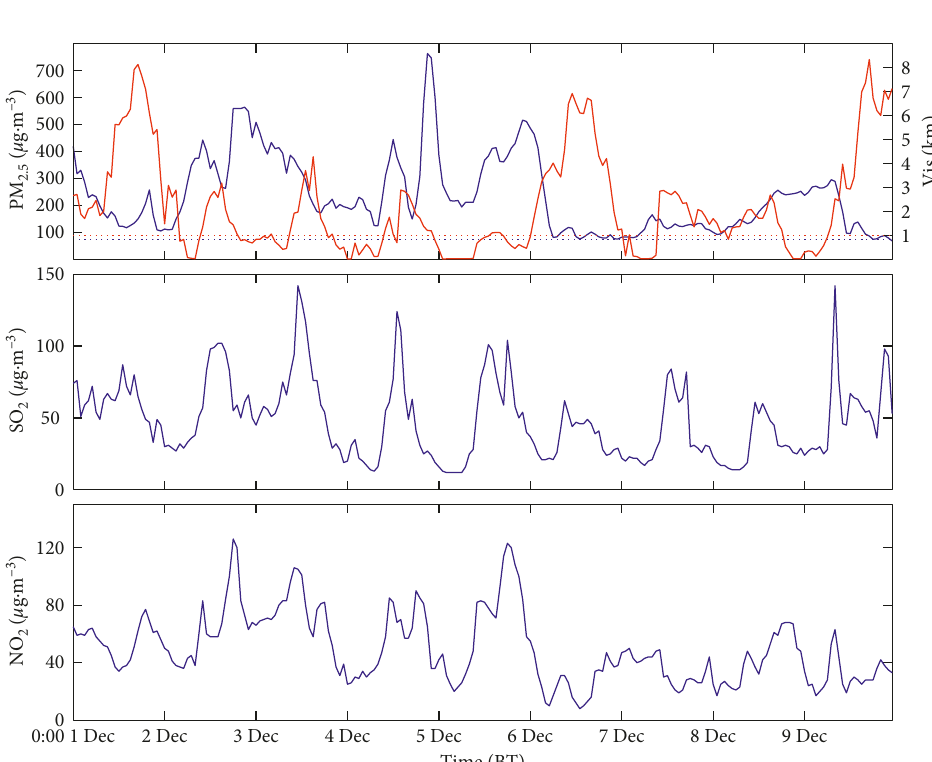
Figure 4: Time series of air pollutants concentration at the Yancheng site from 1 to 9 December 2013. The dotted red line represents 1km visibility, and the dotted blue line represents 75 μ g